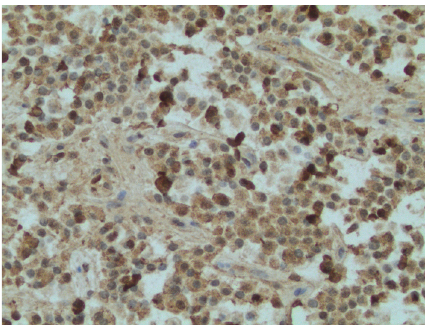
Figure 3: Pathology of pancreatic neuroendocrine tumor with positive staining for